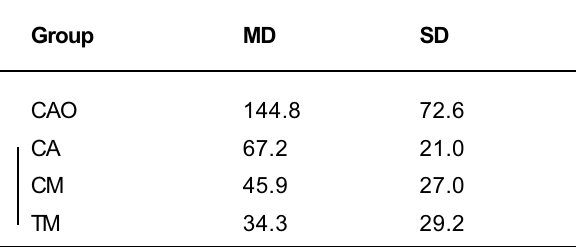
TABLE 1- Mean values of marginal discrepancy (in µm) and standard deviation (SD) for each cementation